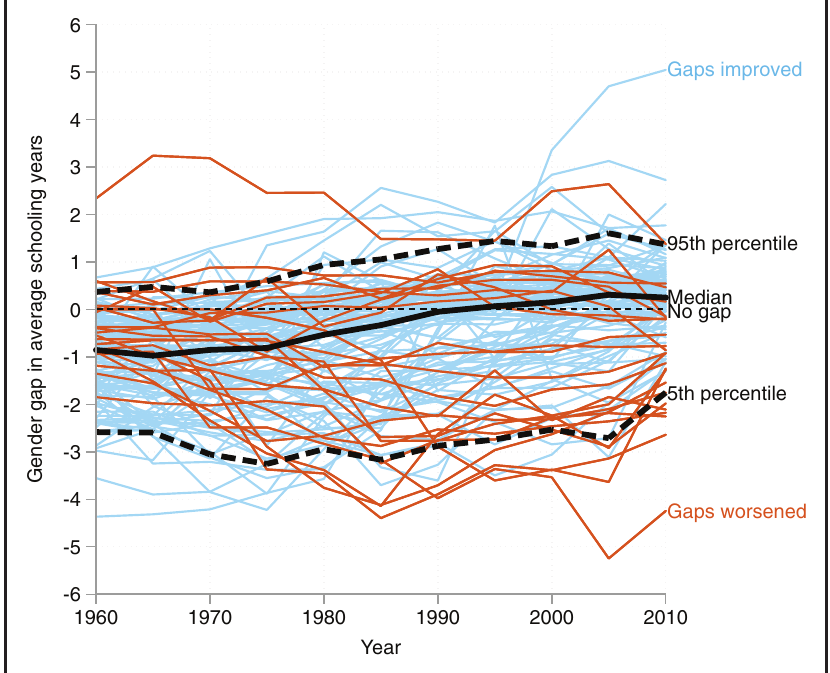
Figure 7 Change in Gender Gaps in Educational Attainment for Younger